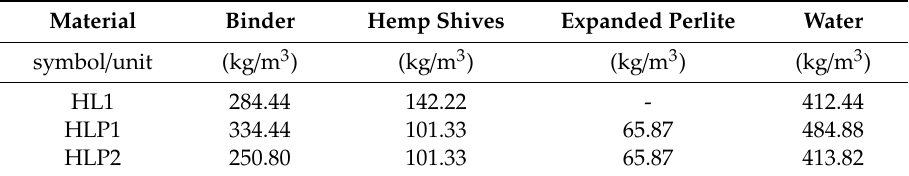
Table 1. Mixture amounts (by weight).